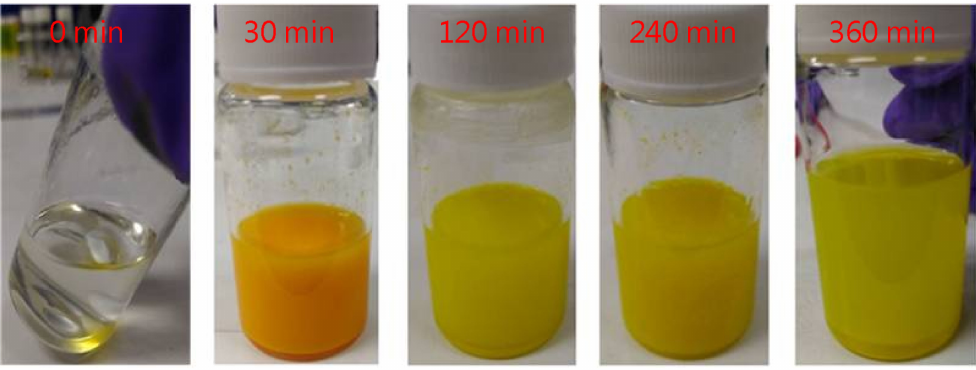
Figure 2. Pictures of QD-MAPbBr 3 solutions for different reaction